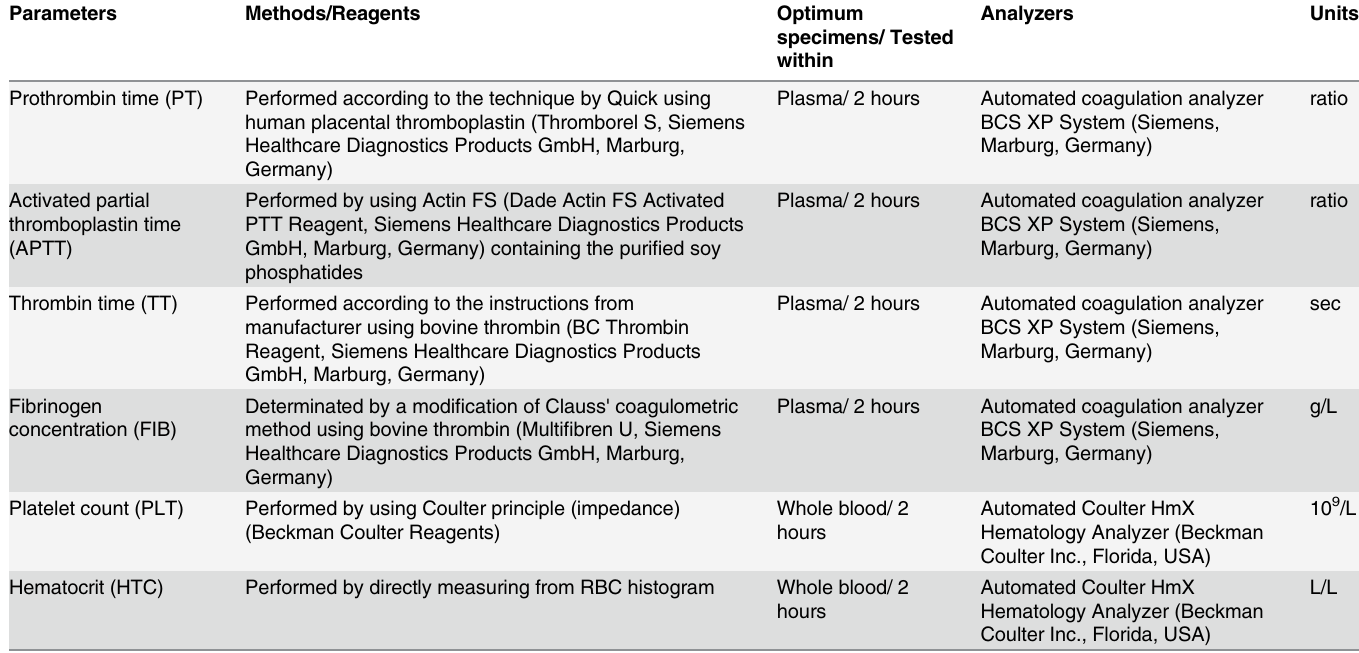
Analyzers Units specimens/ Tested within